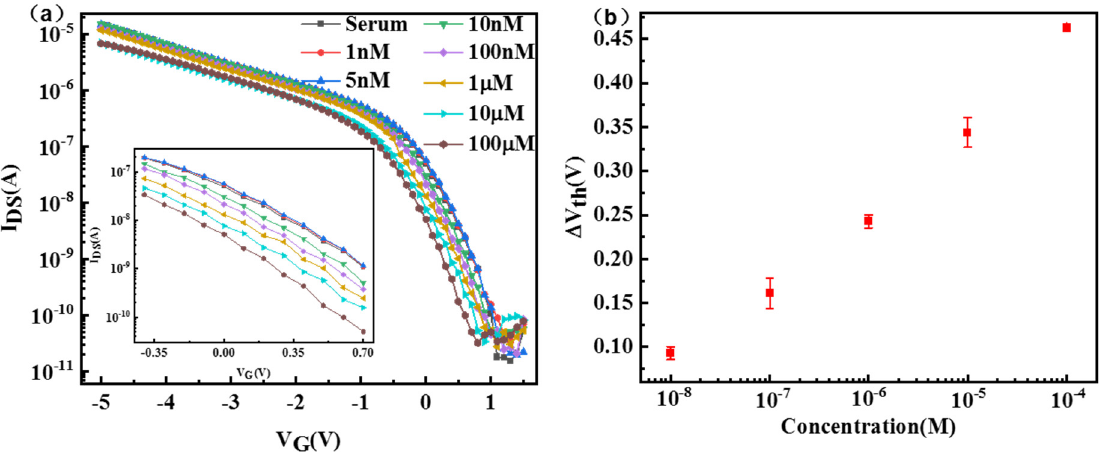
Figure 7. ( a ) Transfer curves and ( b ) the detailed ∆ V th of APTMS/PEG/SiNW − FET biosensors for detecting glucose in serum samples.